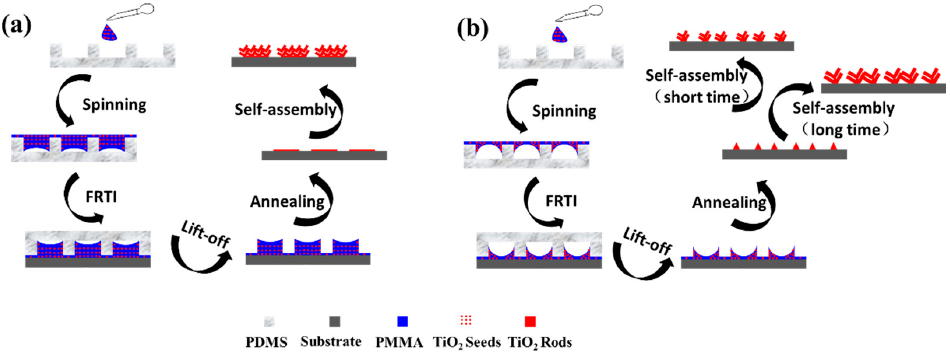
Figure 1. Schematic illustration of the fabrication process of TiO 2 lines without residual layer. ( a ) When the concentration of PMMA/Ti 4+ solution is high. ( b ) When the concentration of PMMA/Ti 4+ solution is low.